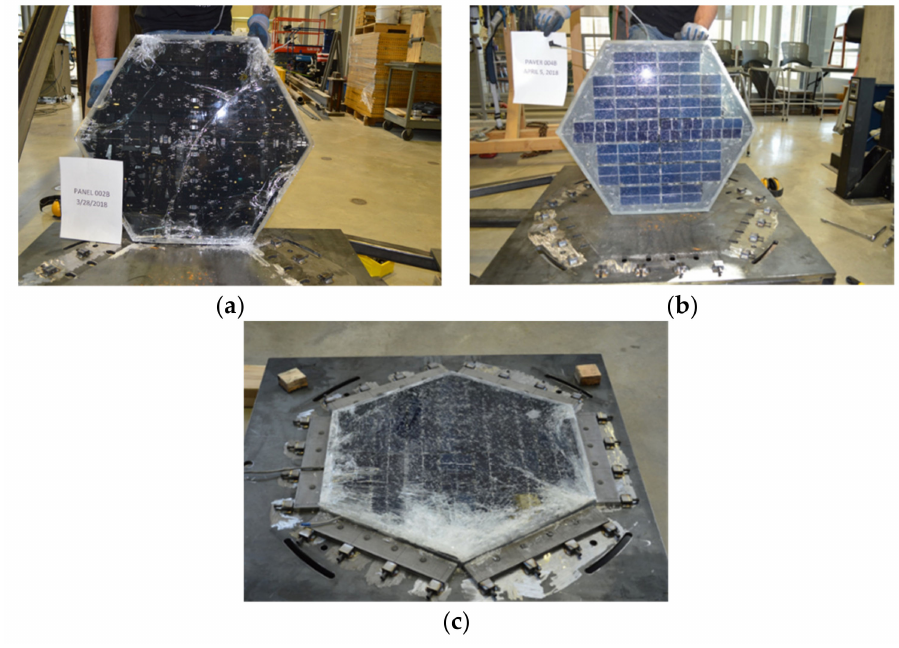
Figure 17. Post-test failure mode; ( a ) Paver 002B, ( b ) Paver 004B, and ( c ) Paver